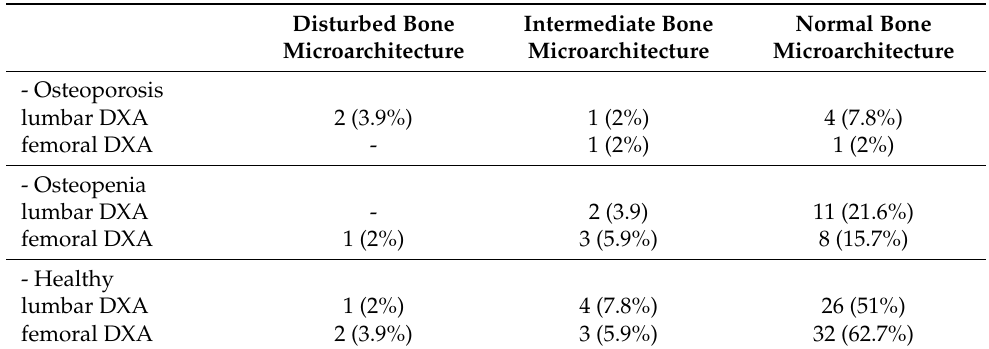
Table 2. The incidence (number, %) of disturbed (<1.23), intermediate ( ≥ 1.23 and <1.31), or normal ( ≥ 1.31) bone microarchitecture and BMD status—osteoporosis (T-score ≤ 2.5 in patients aged ≥ 50 or Z-score ≤ − 2 in patients aged <50), osteopenia (T-score < − 1 and > − 2.5), and healthy (T-score was ≥− 1 and Z-score > − 2 in patients aged <50). DXA—dual X-ray absorptiometry.